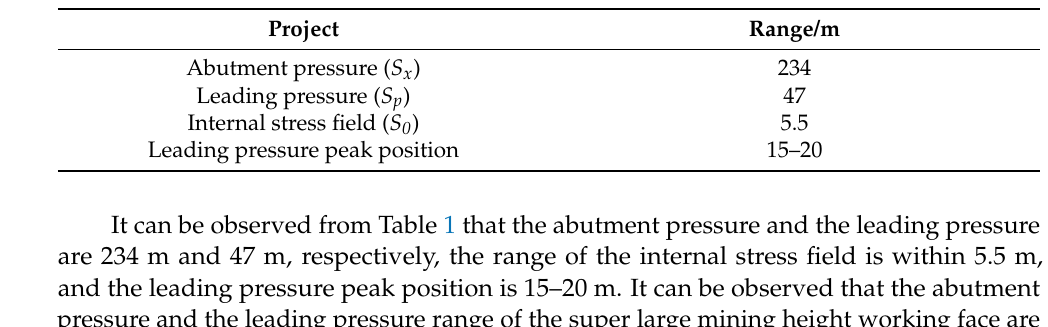
Table 1. Theoretical prediction of abutment pressure distribution in 108 working face.